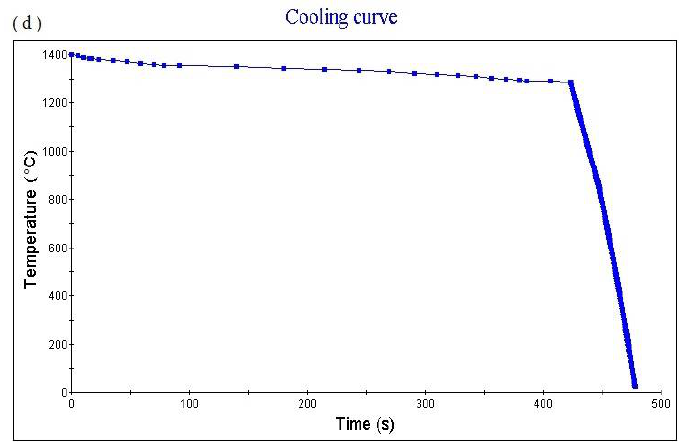
Figure 2. Solidification physical properties. Physical properties for Fe 25 Cr 25 Ni 25 Al 25 multi-principle element alloys. ( a ) general physical properties (fraction solid–temperature); ( b ) general physical properties (fraction liquid–temperature); ( c ) wt.% element in liquid–temperature; ( d ) cooling curve (temperature–time). Figure 3a is the fraction solid (at)–temperature (°C) curve of Fe 25 Cr 25 Ni 25 Ti 6.25 Al 18.75 alloy (subscript is atomic percentage). The figure shows that as the temperature rises, the alloy gradually melts, and the melting point is 1140.41 °C. Fraction solid (at): 1.0. Then as the temperature increases, the solid phase volume fraction gradually decreases. When the temperature increases to 1334.85 °C, fraction solid (at): 0.0. Figure 3b is the fraction liquid (at)–temperature (°C) curve of Fe 25 Cr 25 Ni 25 Ti 18.75 Al 6.25 alloy (subscript is atomic percent- age). The figure shows that as the temperature increases, the volume fraction of the liquid phase in the alloy changes accordingly. The multi-principal element alloy has a fixed melt- ing temperature, which is 1140.41°C, currently fraction liquid (at): 0.0. It absorbs heat dur- ing the melting process. When the temperature rises to 1146.89 °C, fraction liquid (at): 0.16. When the temperature rises to 1289.85 °C, fraction liquid (at): 0.88. Then as the tem- perature rises, the alloy gradually melts. When the temperature rises to 1334.85 °C, frac- tion liquid (at): 1.0. As the temperature rises, fraction liquid (at) remains unchanged. Fig- ure 3c shows the element in liquid (wt.%)—temperature curve of the alloy. As the tem- perature increases, the percentage content of various elements in the alloy liquid phase will change. Figure 3d shows the cooling curve of the alloy. The cooling rate obtained for the cooling curve is 1.0 °C/ s . when the cooling time is 516.5 s and the temperature is 1140.41 °C, the cooling rate can be adjusted to obtain cooling curves with different cooling rates.